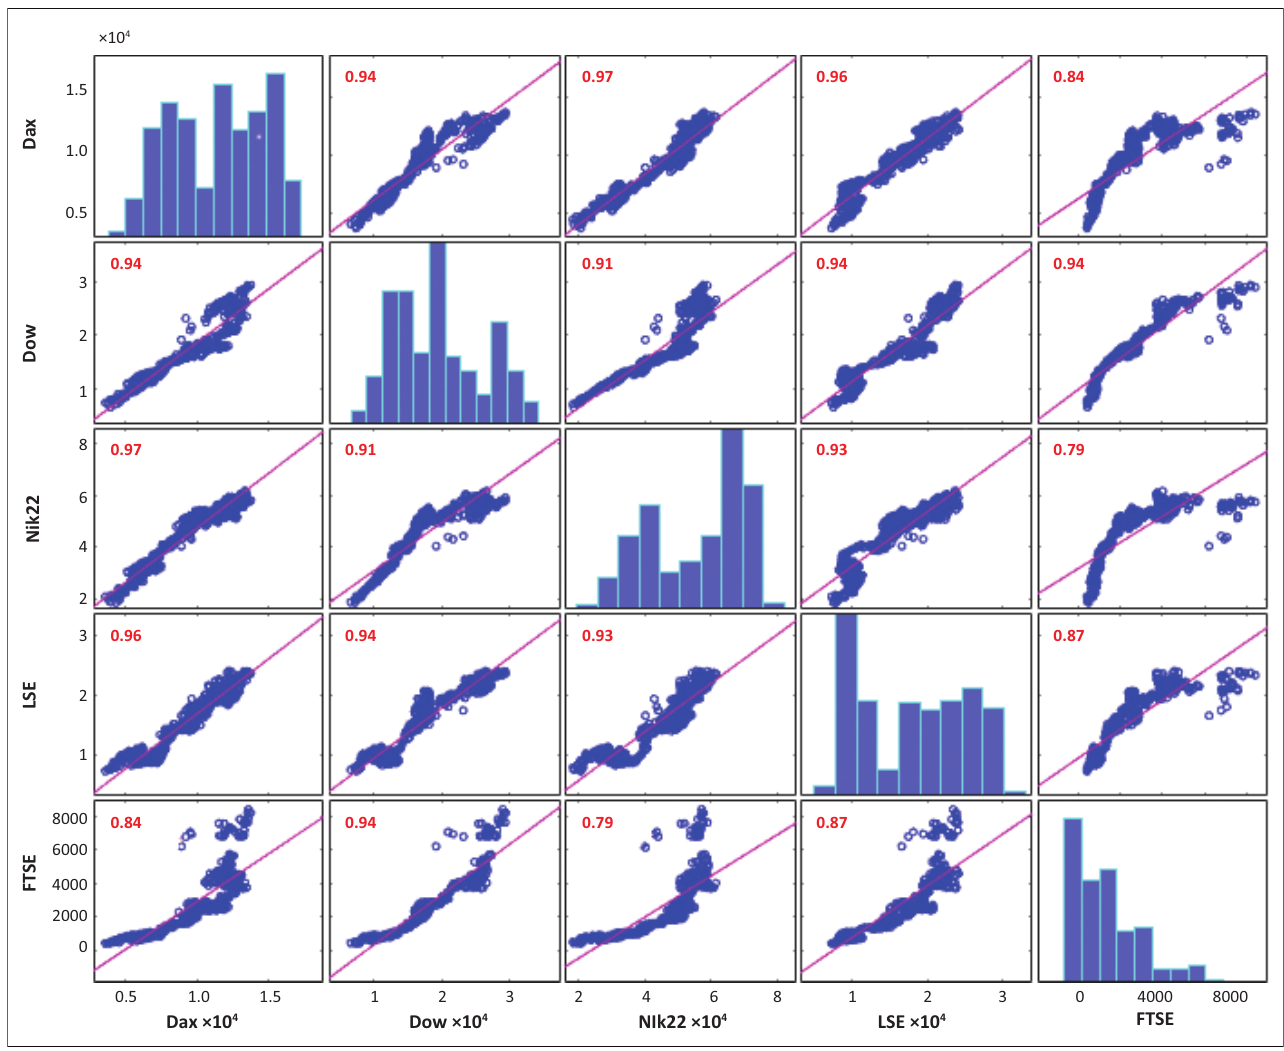
FIGURE 4: Correlation matrix indicating the level of correlation, which exists between these markets.